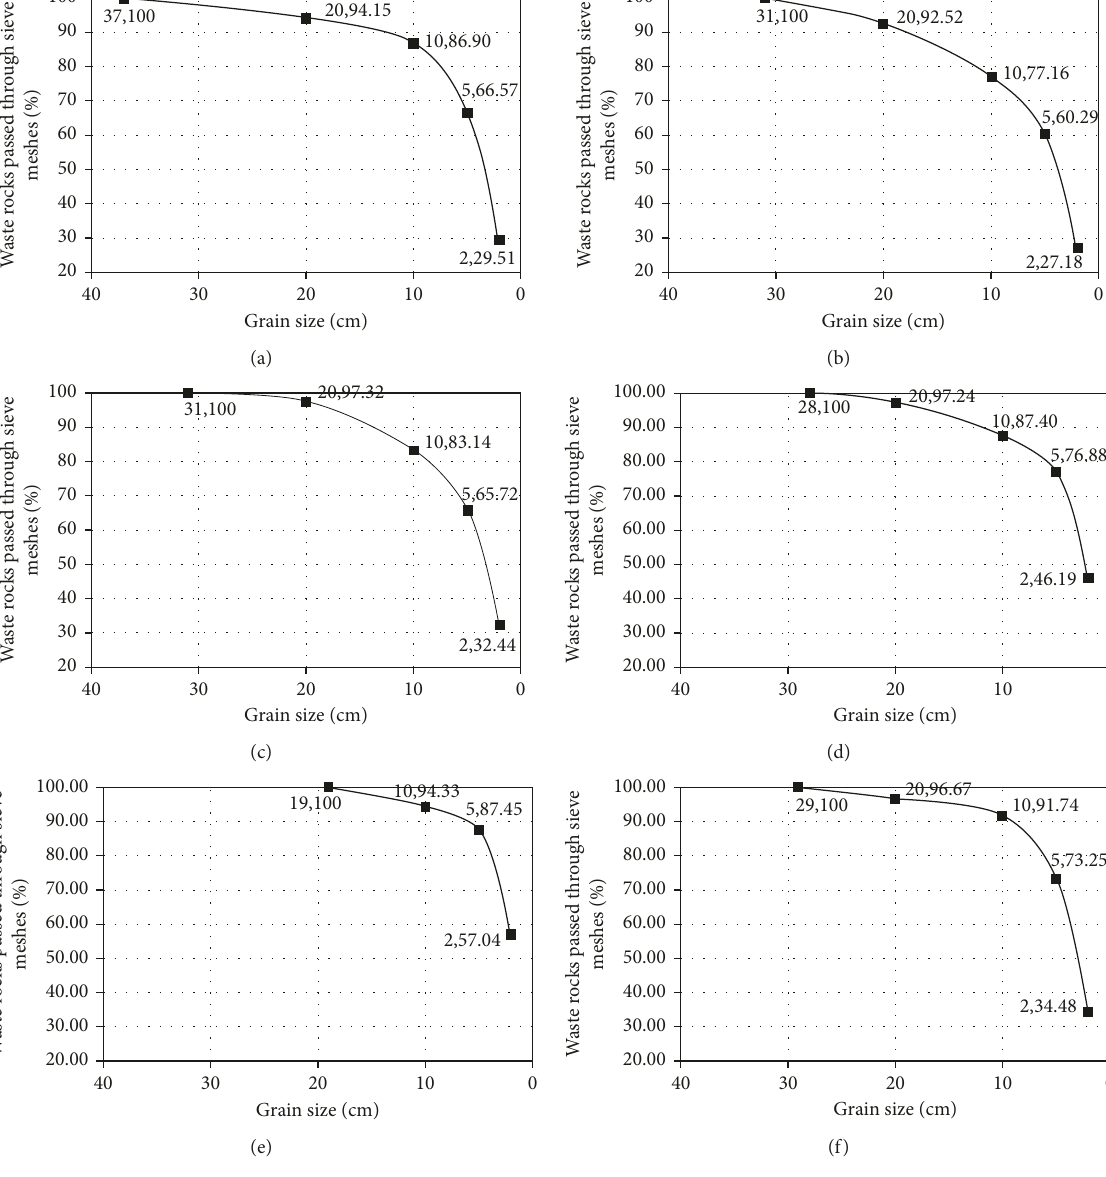
Figure 4: Grain size distribution curve of waste rocks. (a) Sample Pit J1. (b) Sample Pit J2. (c) Sample Pit J3. (d) Sample Pit N1. (e) Sample Pit N2. (f) Sample Pit